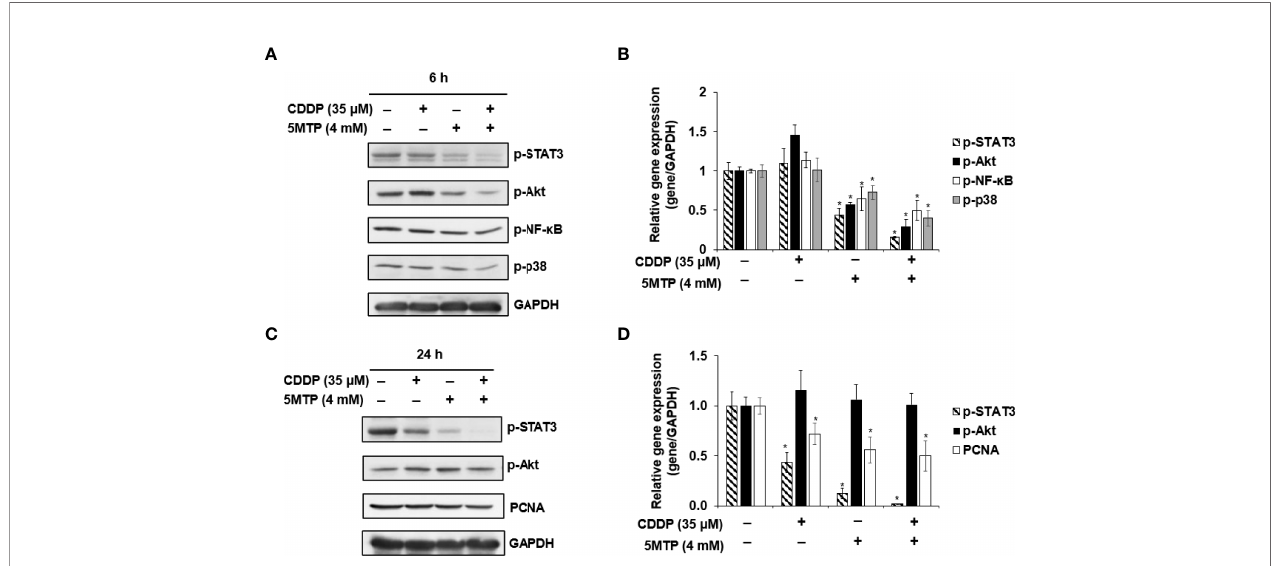
FIGURE 3 | Inhibitory effect of the combination treatment of Cisplatin (CDDP) and 5-methoxytryptophan (5-MTP) on proliferation involved in the STAT3 signaling pathway. SCC4 and SCC25 cells were treated with CDDP, 5-MTP, or both at indicated concentrations for 6 h (A, B) or 24 h (C, D) . Total cell lysates were extracted at the indicated time points and subjected to western blot with relevant antibodies. GAPDH served as an equal loading control in western blot. Asterisks indicate signi fi cant difference in drug-treated cells at indicated concentrations singly in comparison with DMSO-treated cells. *P <